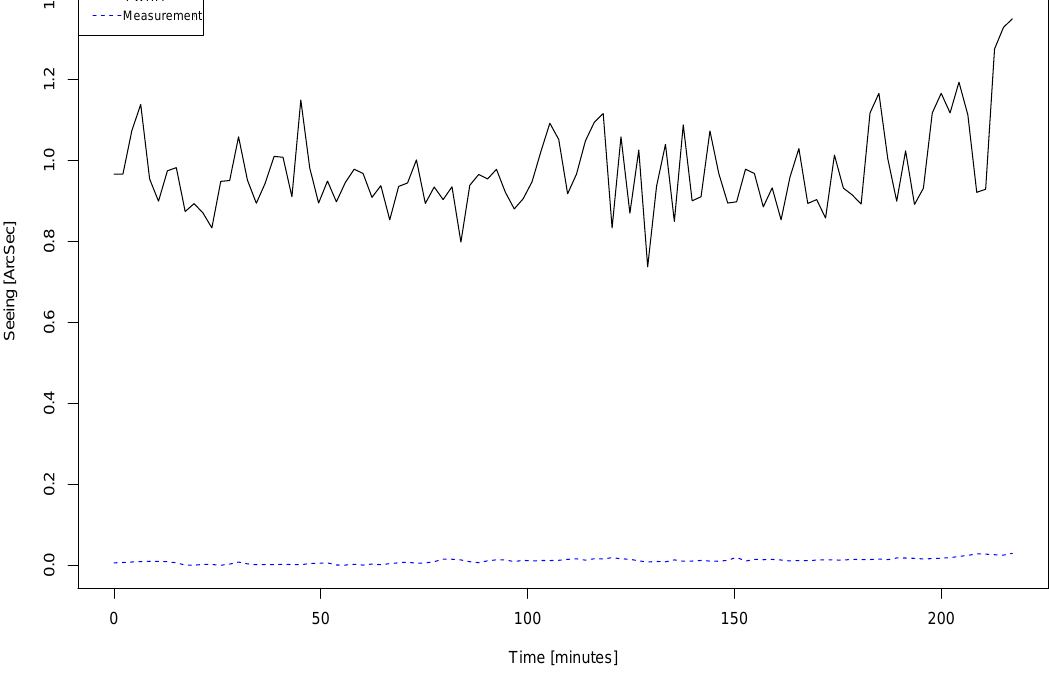
Figure 17. Local seeing calculation from FWHM and